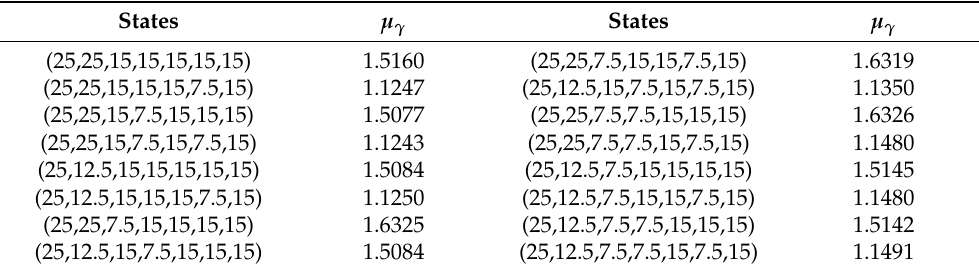
Table 5. List of reserve capacity in capacity status of each road section.